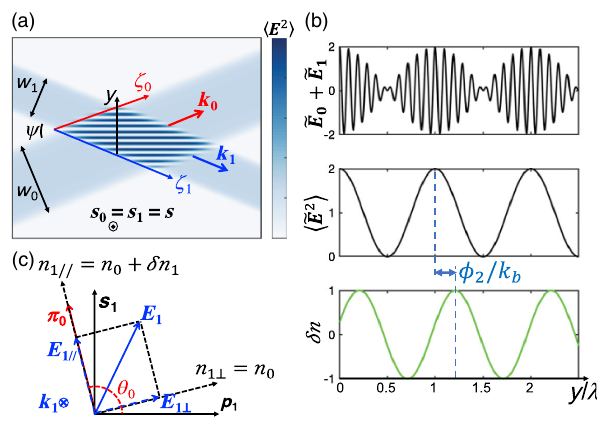
FIG. 1. (a) Interaction geometry between two light waves with wave vectors k 0 , k 1 and transverse widths w 0 , w 1 , showing the beat wave pattern in the interaction volume. (b) The beat wave ˜ E þ ˜ E from 0 1 leads to a time-averaged modulation in intensity þ ˜ E Þ 2 i , which in turn generates a refractive index modu- hð ˜ E 0 1 lation δ n ; the refractive index modulation can be spatially shifted from the time-averaged beat wave intensity pattern, by a phase shift ϕ 2 . (c) Geometry of the linear wave mixing interaction: when I 0 ≫ I 1 , the probe E 1 experiences a different refractive index n 1 k ¼ n 0 þ δ n 1 along the direction of π 0 , the projection of p s E 0 in ( 1 , 1 ), whereas the refractive index n 1 ⊥ along the direction orthogonal to π 0 remains